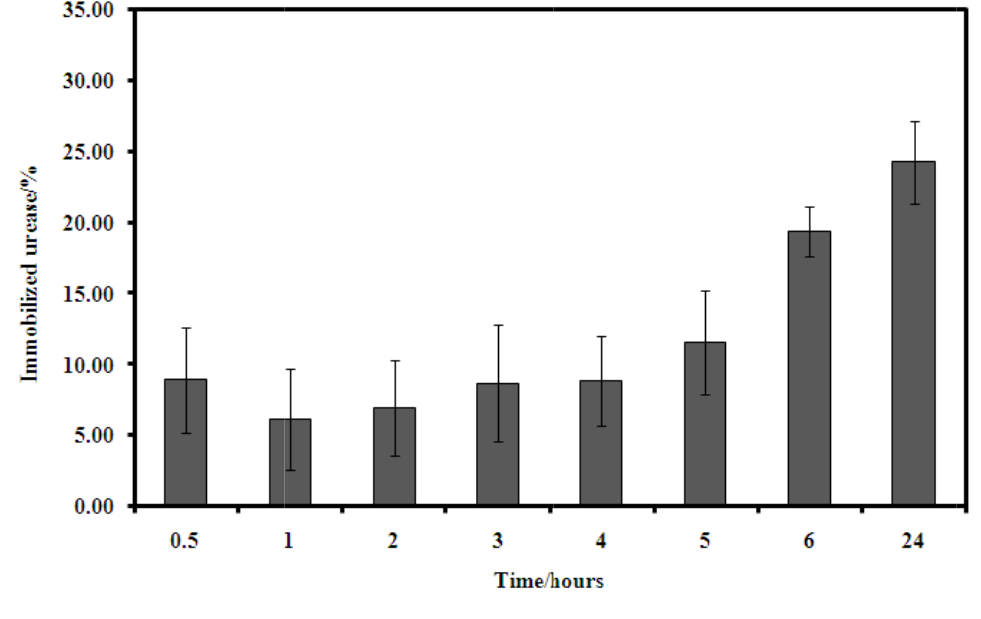
n the urine urea biosen biosensor de